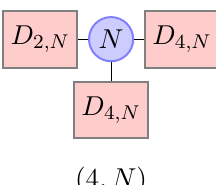
Figure 3 . We may further generalize the (3 , 2) theory by considering a diagonal exactly marginal SU( N ) gauging of four D 2 (SU( N )) := D 2 ,N theories. Here gcd(2 , N ) = 1 .